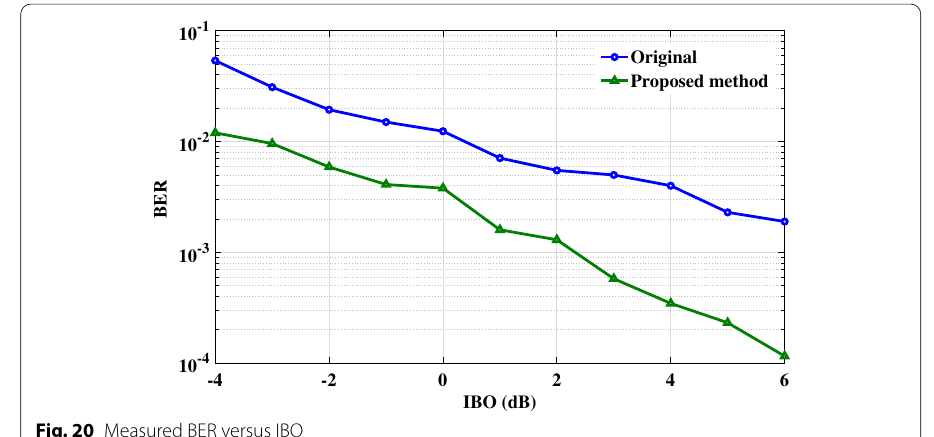
Fig. 20 Measured BER versus IBO